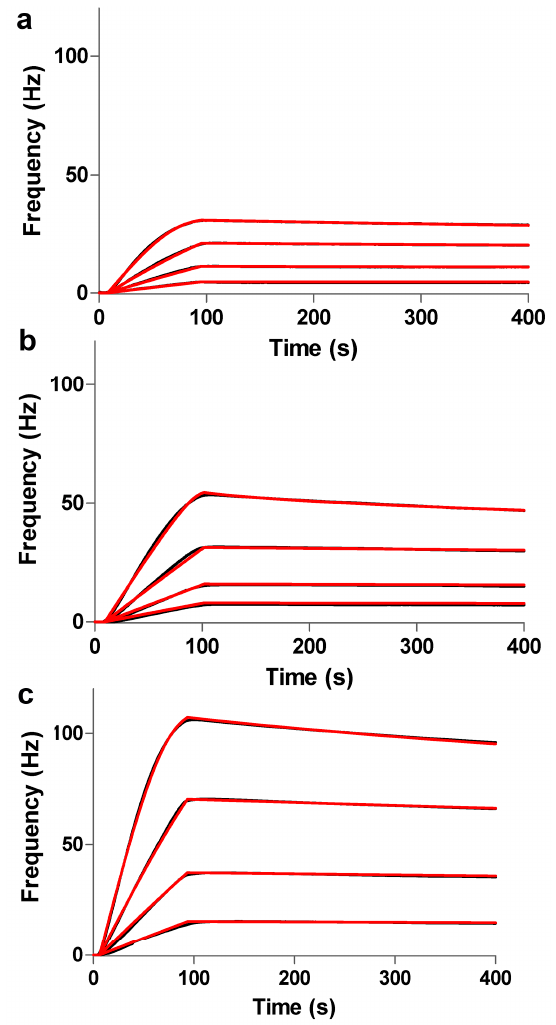
Figure 5. ( a ) Kinetic evaluation of the interaction on the 2D surface, myoglobin at 0.03, 0.06, 0.12, and 0.24 µ M, was injected over the surface, respectively; ( b ) Kinetic evaluation on the 3D carboxymethyl dextran (500 kDa) surface, myoglobin at 0.03, 0.06, 0.12, and 0.24 µ M, was injected over the surface, respectively; ( c ) Kinetic evaluation on the 3D carboxymethyl dextran (2000 kDa) surface, myoglobin at 0.03, 0.06, 0.12, and 0.24 µ M, was injected over the surface, respectively. In Figure 5a–c, the measured responses are presented in black lines, the theoretical 1:1 fit generated by the ClampXP software are overlaid in red lines.